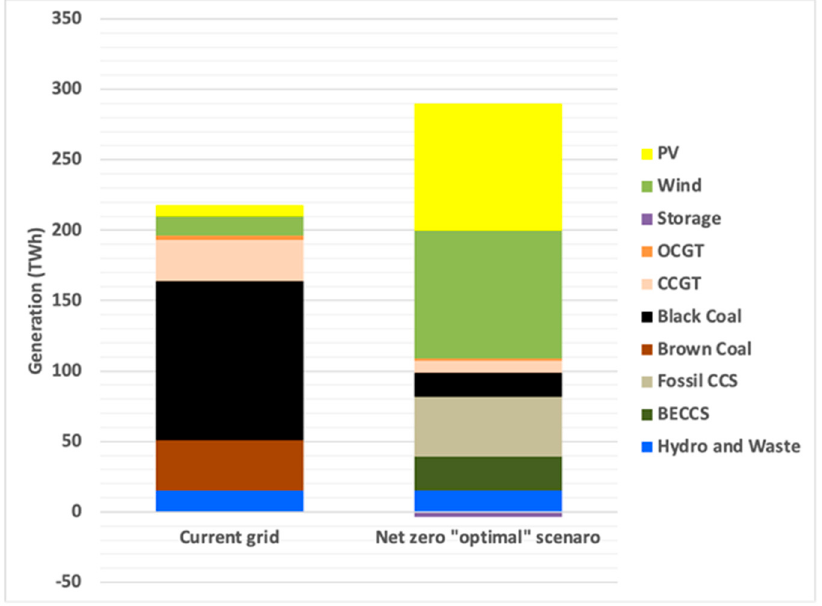
Figure 3. Current grid and net zero “no constraints” scenario generation (TWh) by technology, produced using the MEGS model.